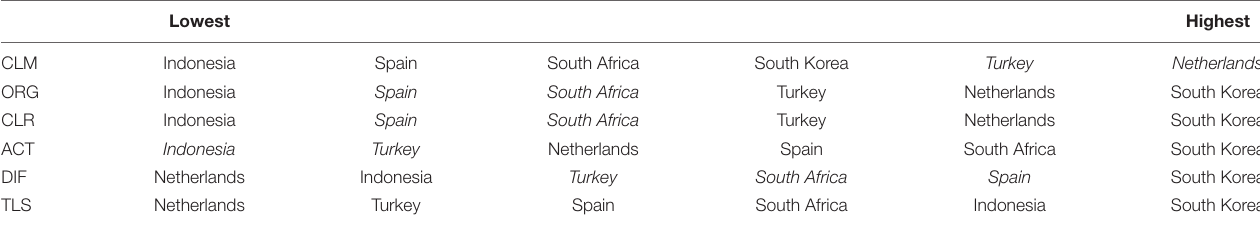
TABLE 9 | Ranking of latent means of the scalar invariance Multi-Group Confirmatory Factor Analysis (MGCFA) model (including significances).